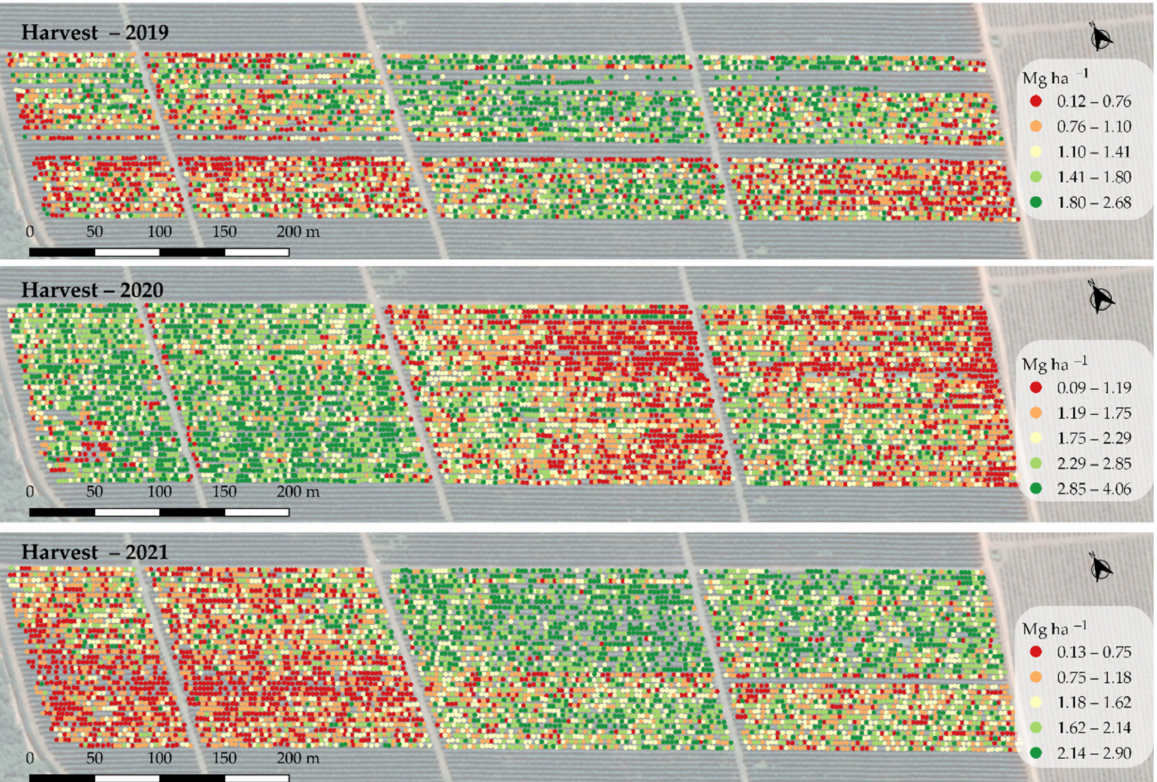
Figure 6. Filtered processed coffee yield map data obtained by the yield monitor for the 2019 harvest; 2020 and